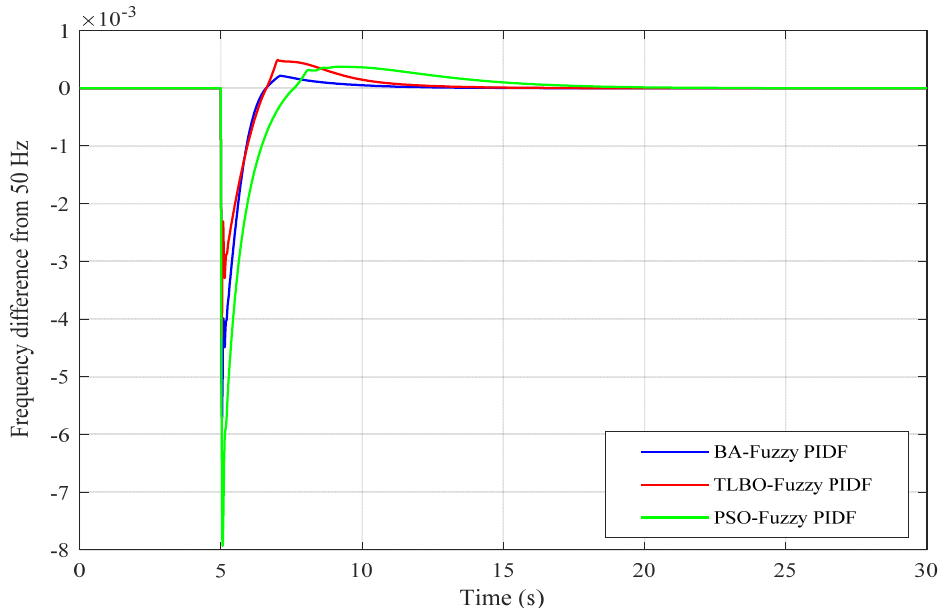
Figure 11. Change in frequency in the GB power system for 0.035 pu load disturbance with tuned Fuzzy PIDF-based ITAE.